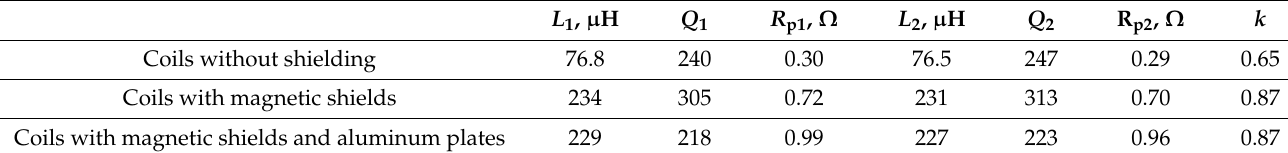
Table 1. Parameters of magnetically coupled coils.